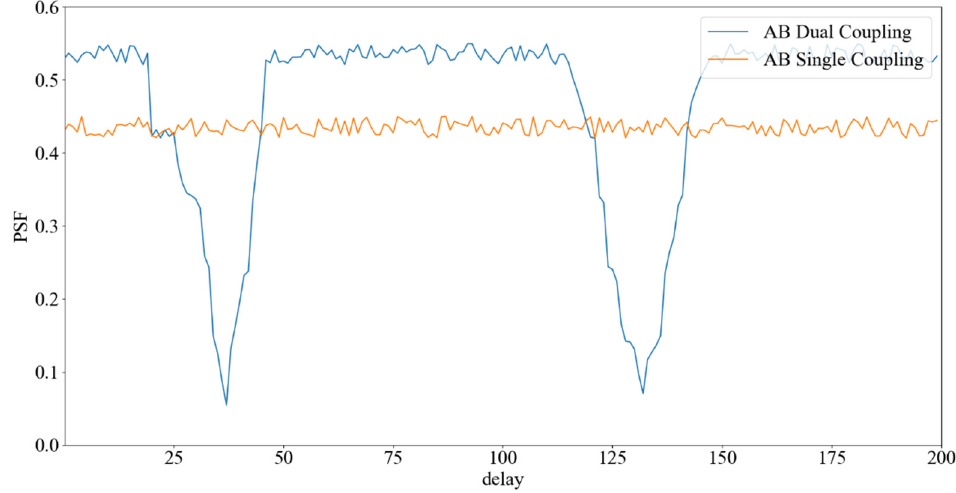
Figure 4. Effect of time delay of two motif model on PSF.